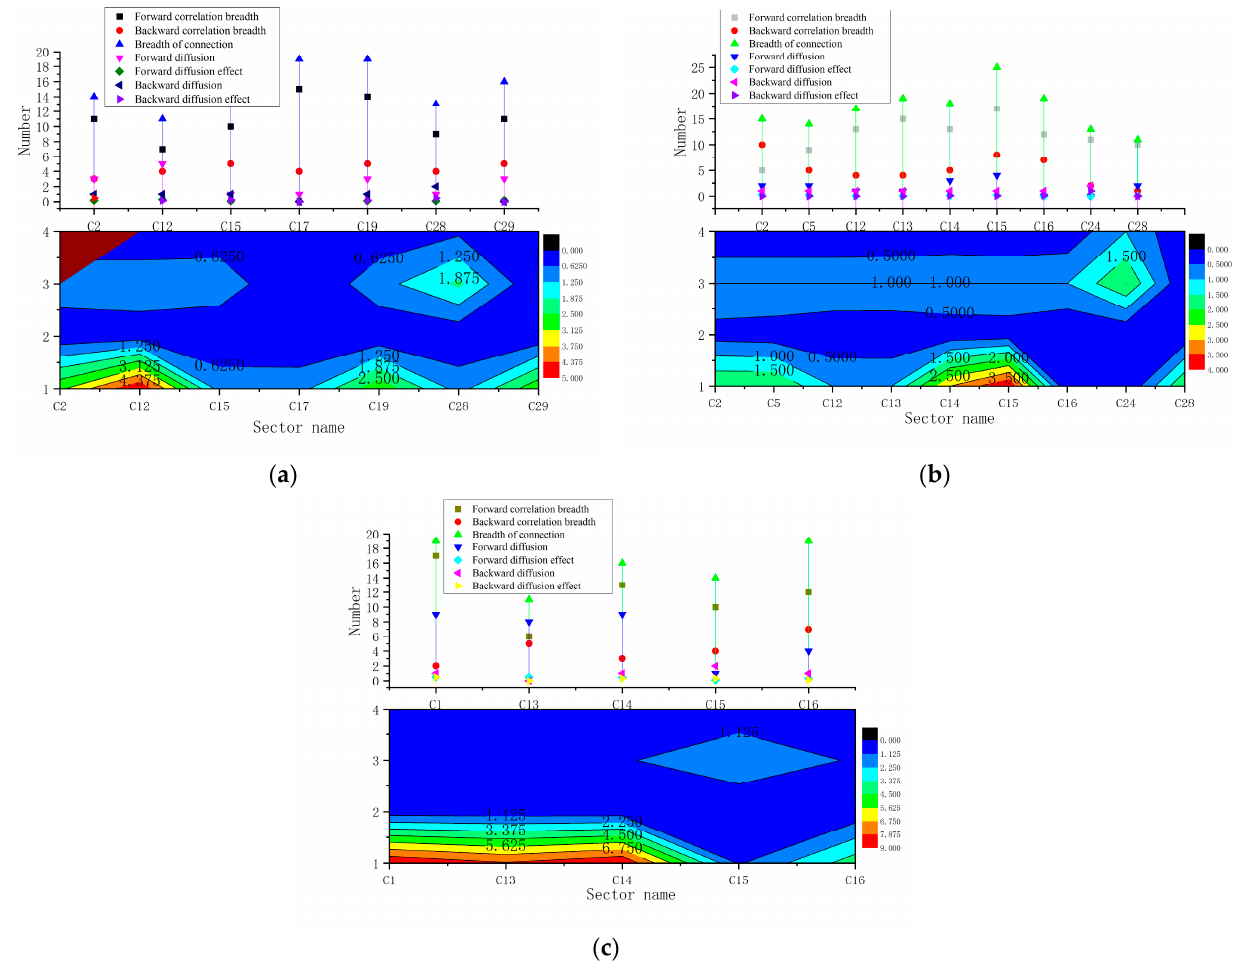
Figure 11. Diffusivity test for alternative key carbon-emitting industry sectors in Hei-Ji-Liao. ( a ) Diffusivity test in Liaoning; ( b ) Diffusivity test in Jilin; ( c ) Diffusivity test in Heilongjiang.